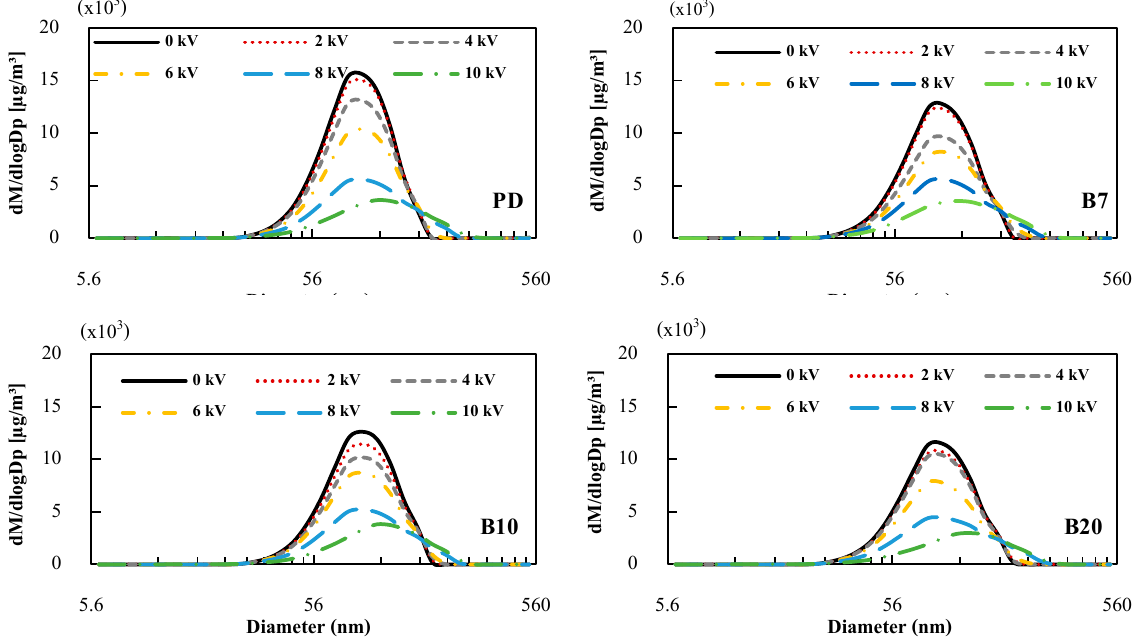
Figure 8. Effect of NTP on particulate mass distribution at an engine speed of 2000 rpm–2000_IMEP 6 bar.